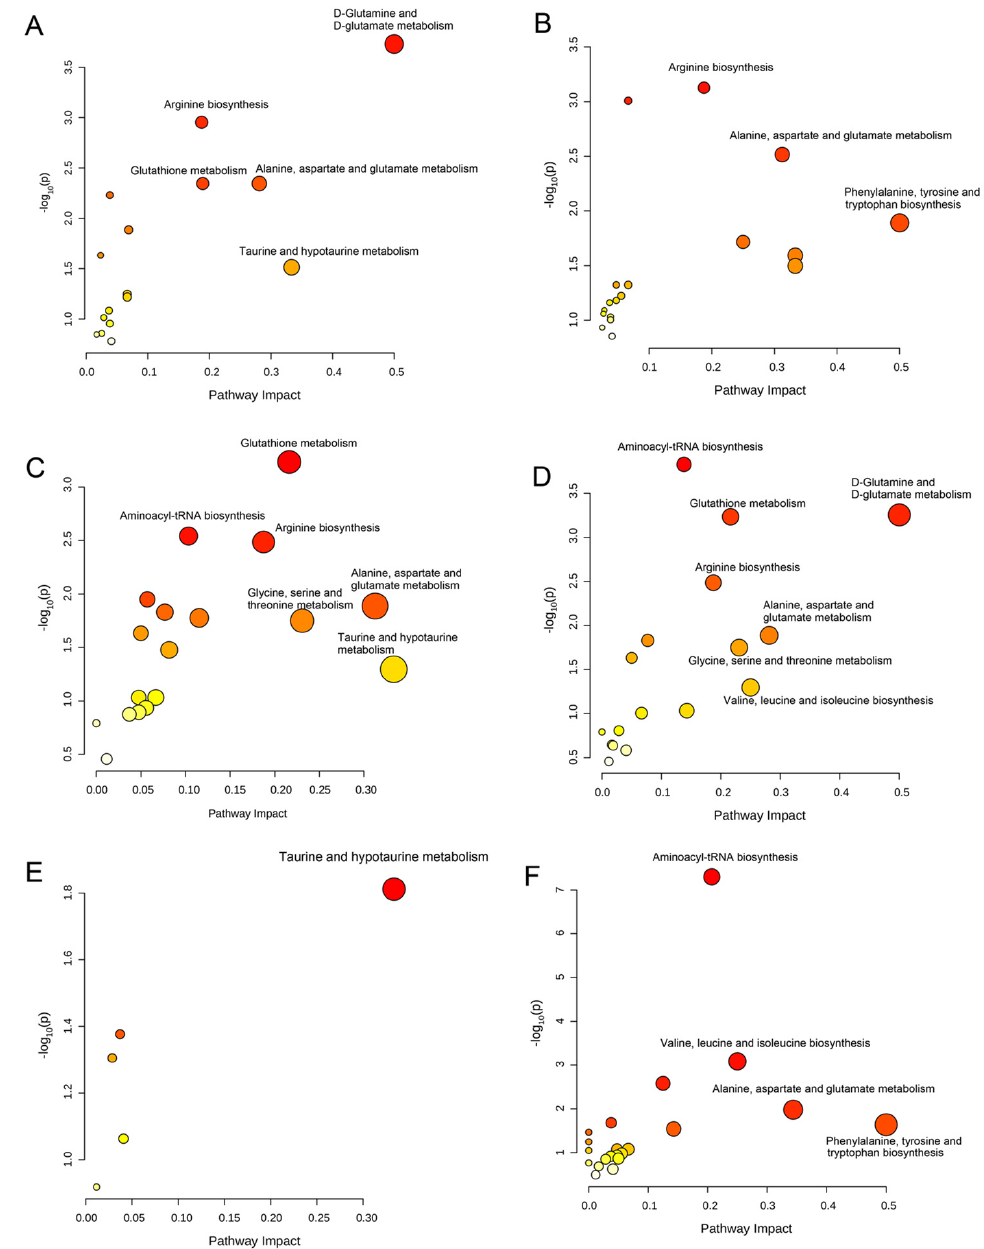
Figure 5. Significantly disturbed metabolic pathways were calculated in comparison between different coumarin derivative groups and the control group. ( A ) CD7 group vs. Control group; ( B ) CD8 group vs. Control group; ( C ) CD9 group vs. Control group; ( D ) CD10 group vs. Control group; ( E ) CD11 group vs. Control group; ( F ) CD12 group vs. Control group.